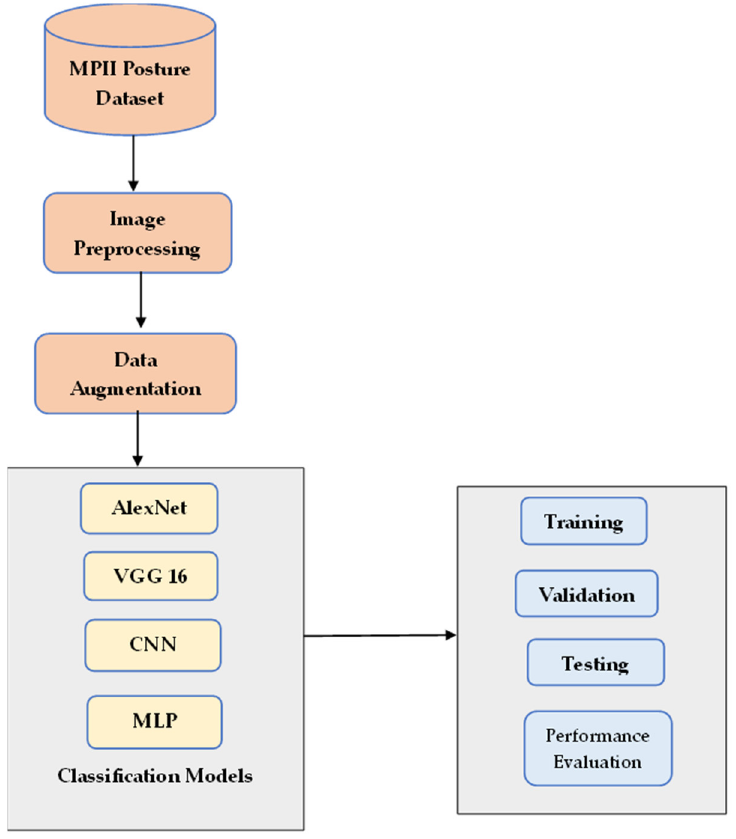
Figure 5. Proposed Image Data augmentation with the model’s architecture.